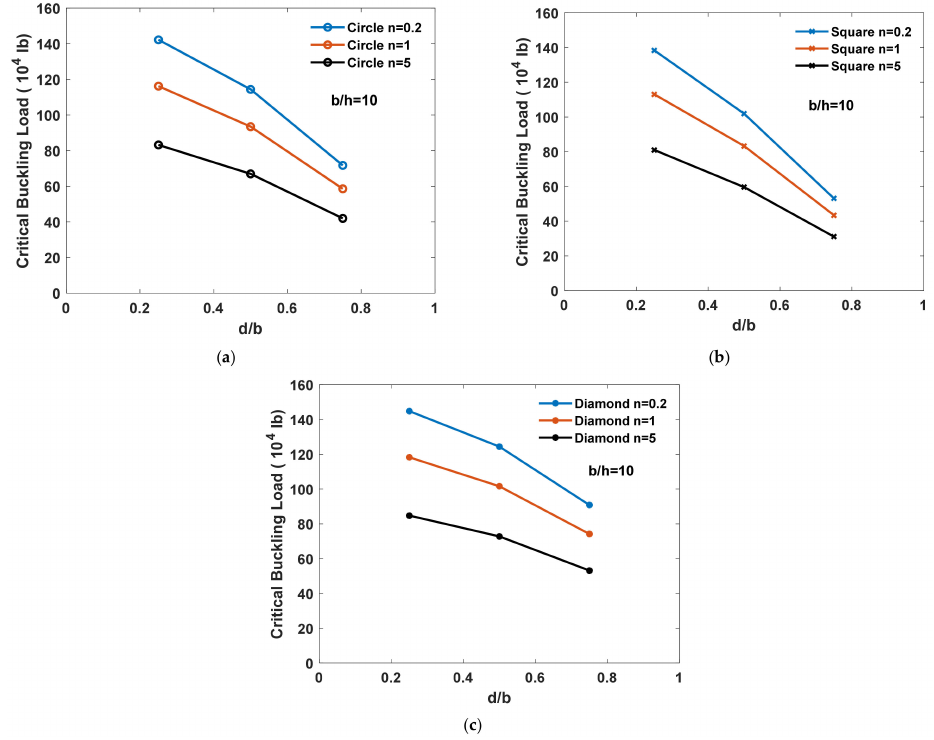
Figure 12. The variation of the opening aspect ratio on the critical buckling load for ( a ) circle, ( b ) square, and ( c ) diamond openings for an aspect ratio b/h =